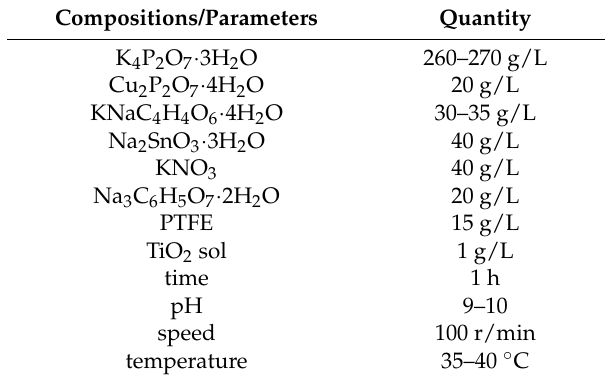
Table 1. Plating solution compositions and technological parameters.